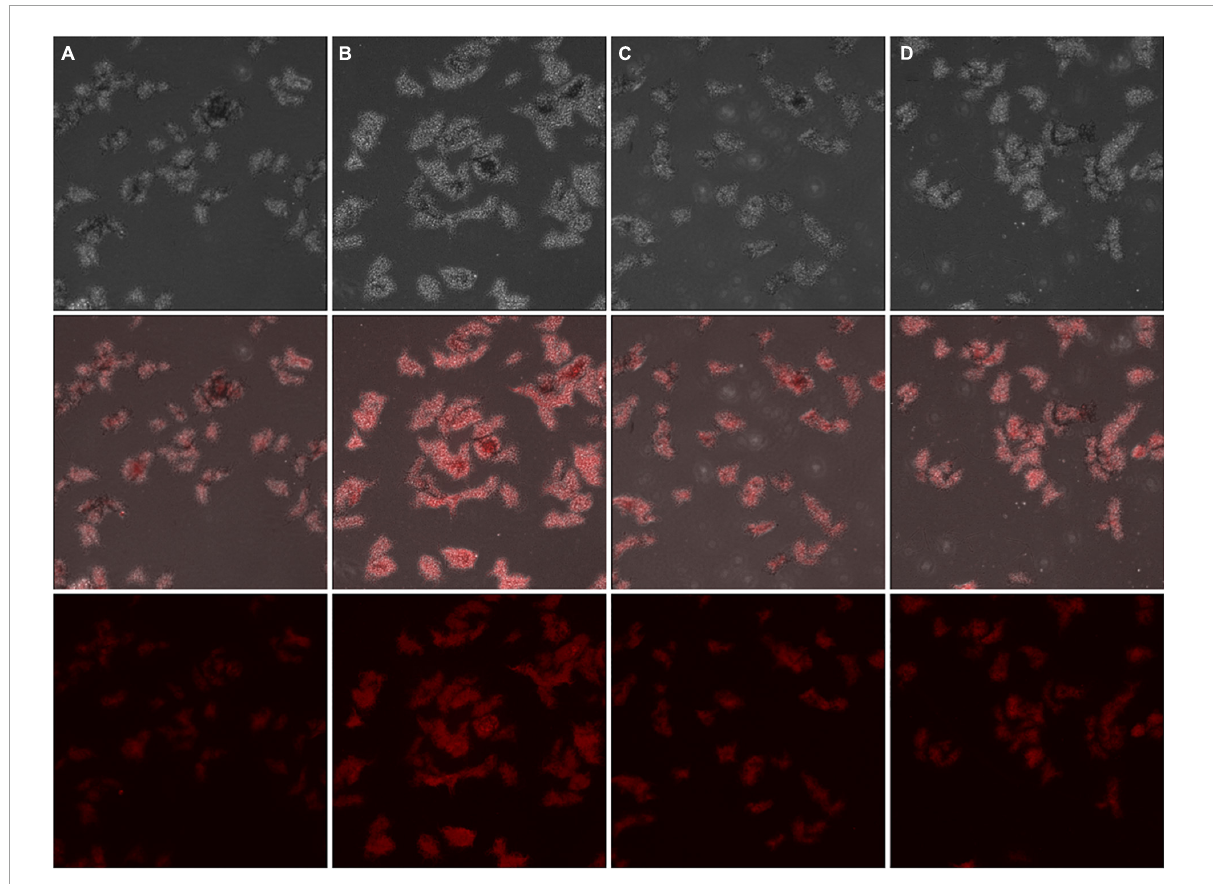
FIGURE5 Fluorescent staining of cell membranes of Streptomyces scabies HP4 treated with Lcn972. The mycelia were treated with (A) Buffer A (negative control); (B) 60 ng/L kanamycin (positive control); (C) 0.5% TritonX-100 (positive control); (D) 2 × MIC Lcn972. Each column represents one